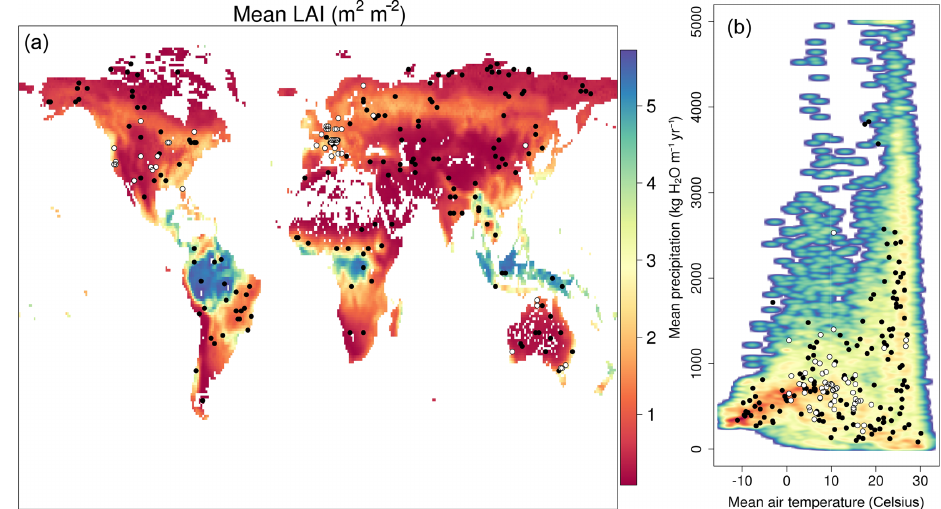
Figure 2. (a) Global (1 × 1 ◦ ) mean LAI estimates (2001–2015) derived from NASA’s MODIS product. (b) Climate space described by mean annual precipitation and temperature (ECMWF’s ERA-Interim; Dee et al., 2011). Shading indicates the point density, with red areas indicating high density. In both plots black circles show the location of SPA calibration sites, while the white circles with black rings show the FLUXNET2015 sites used to provide independent